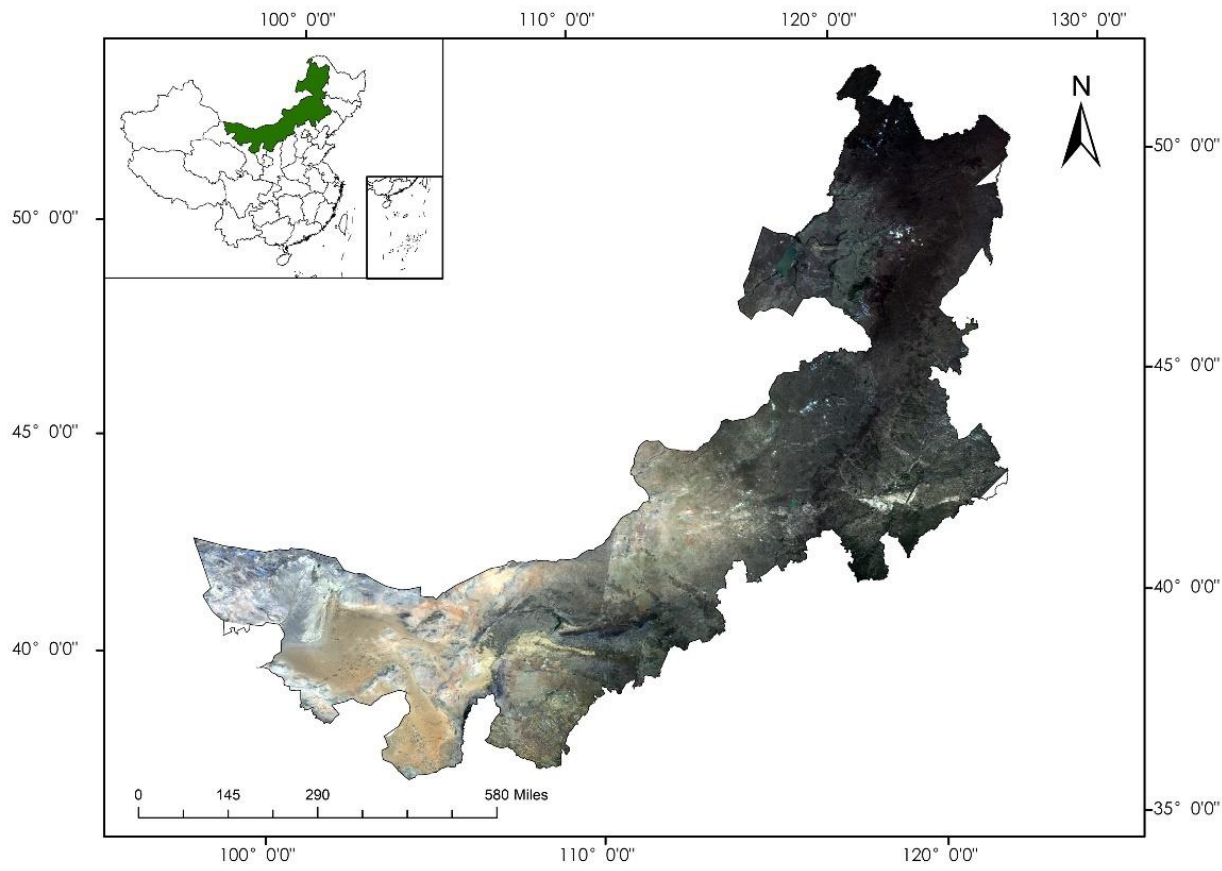
Figure 1. Location of the study area.